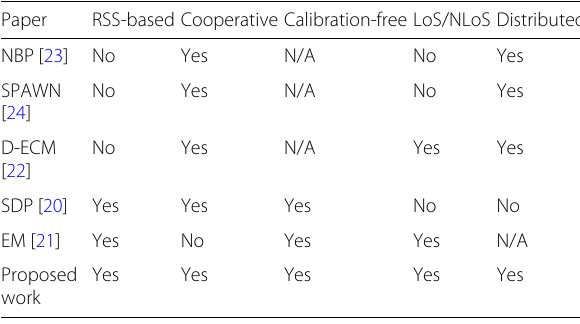
Table 1 Succinct characterization of the related works and the proposed